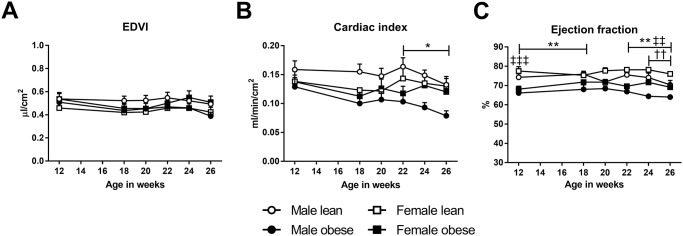
Preserved systolic function in male and female obese ZSF1 rats.A) End-diastolic volume index (EDVI) was not significantly different between groups. B) Cardiac index was decreased in obese male ZSF1 rats, while C) ejection fraction was preserved in all the groups. Means ± SEM. Symbols as in Fig 1.